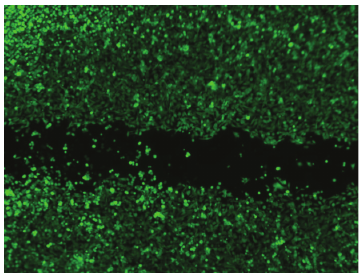
Figure 3: Representative example of live/dead staining of oral epithelial cells after 17h challenge with heat inactivated P. gingivalis and control